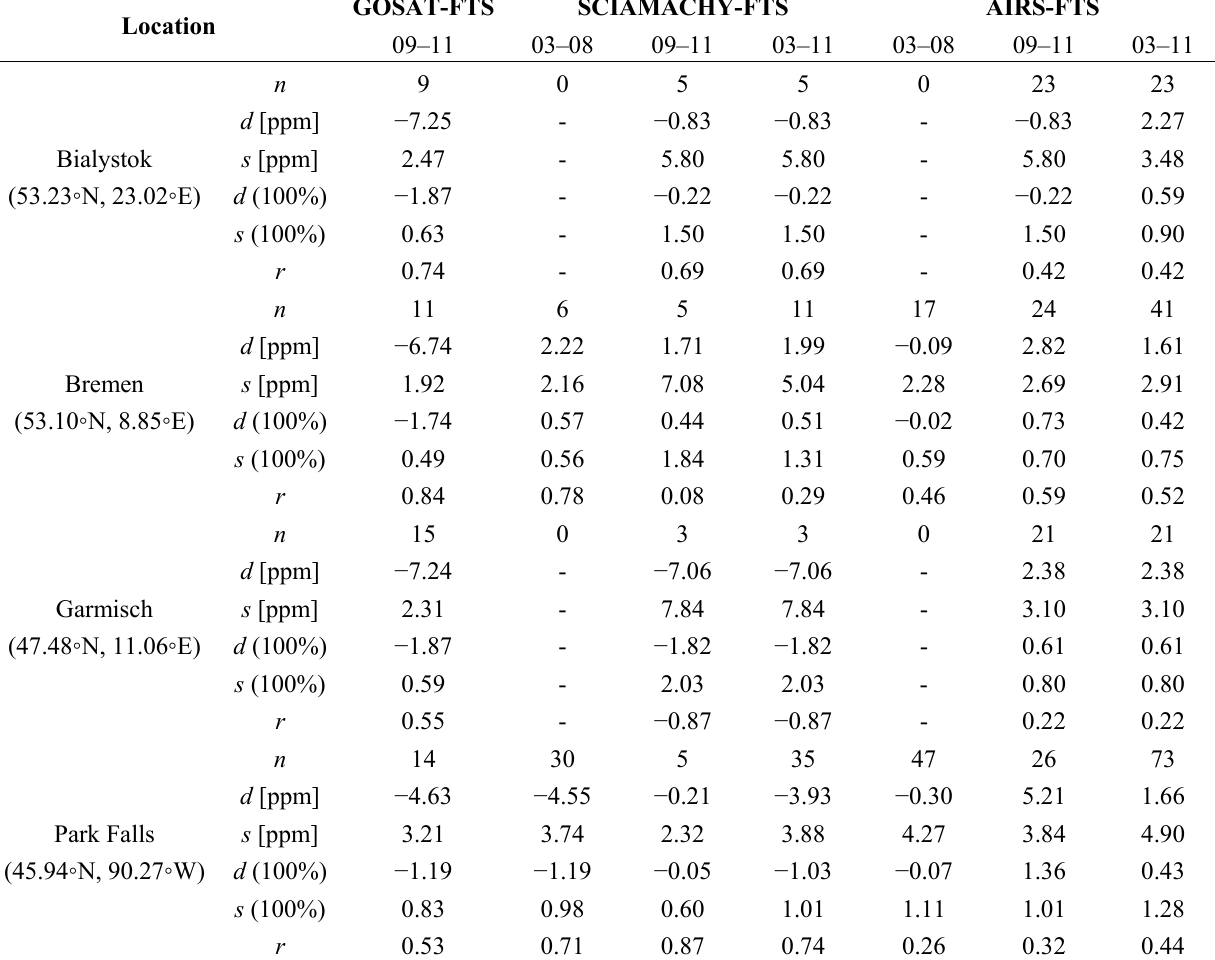
Table 3. XCO validation and comparison results for three satellite products based on 2 monthly data for the entire analyzed time period and for two subperiods from January 2003, to December 2011. Shown are the number of coincident months ( n ) of data availability for satellite data and the comparative data set, the mean difference ( d ) to ground-based (g-b) FTS, the standard deviation of the difference ( s ) and the correlation coefficients ( r ) for the analyzed sites. The global offset is the average mean difference over all sites, the regional precision relative to the reference is the average standard deviation of the difference and the relative accuracy is the standard deviation of the mean